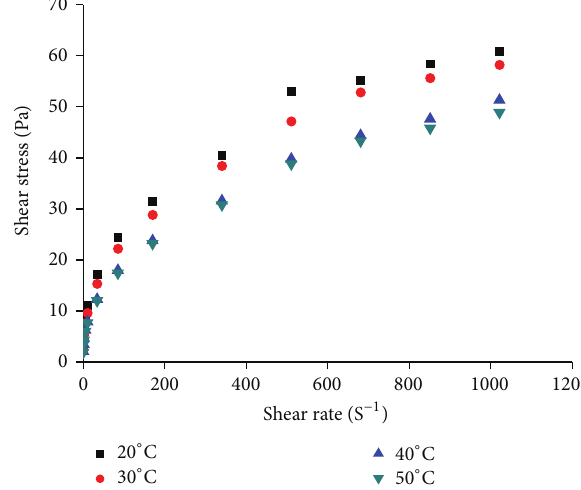
Figure 4: Rheological property under the same temperature and different shear.